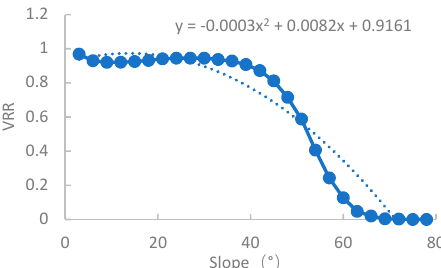
Figure 13. Correlation analysis between VRR and slope.